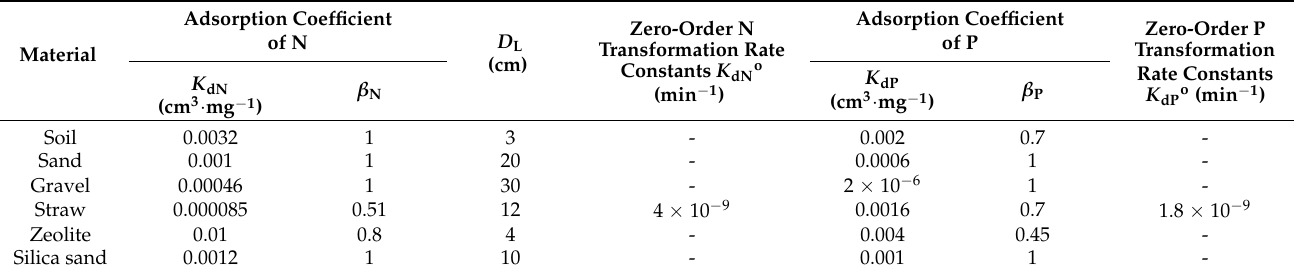
Table 3. Transport and reaction parameters of the soil and filters.